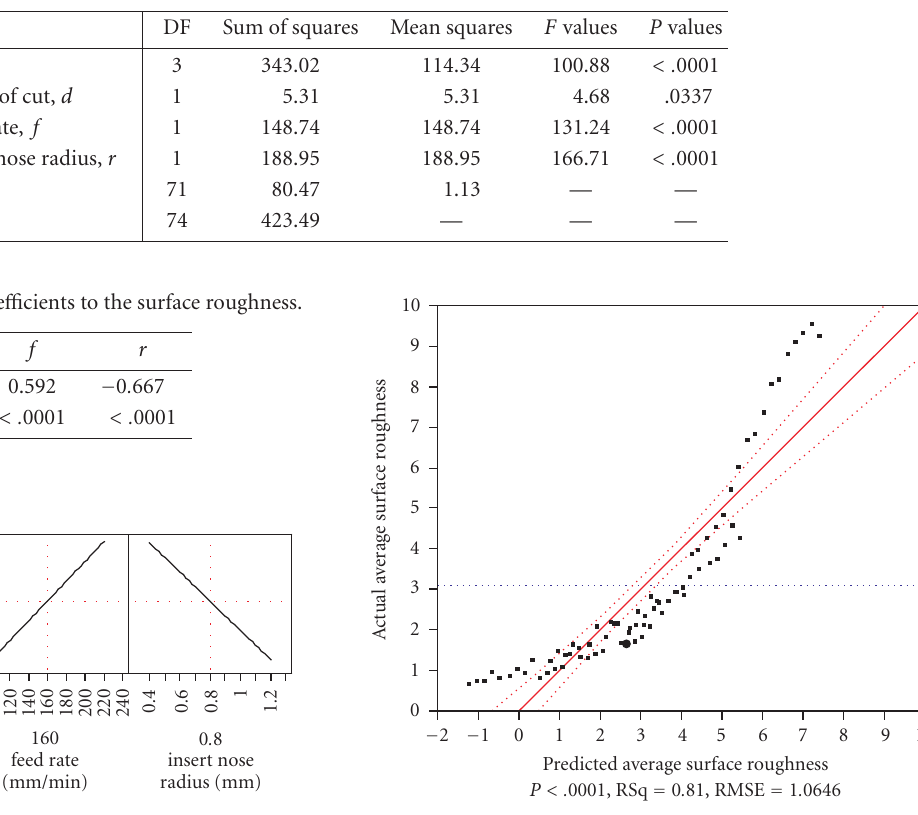
Table 5: ANOVA for surface roughness first-order model in turning of AISI 1030 using cemented carbide tools.